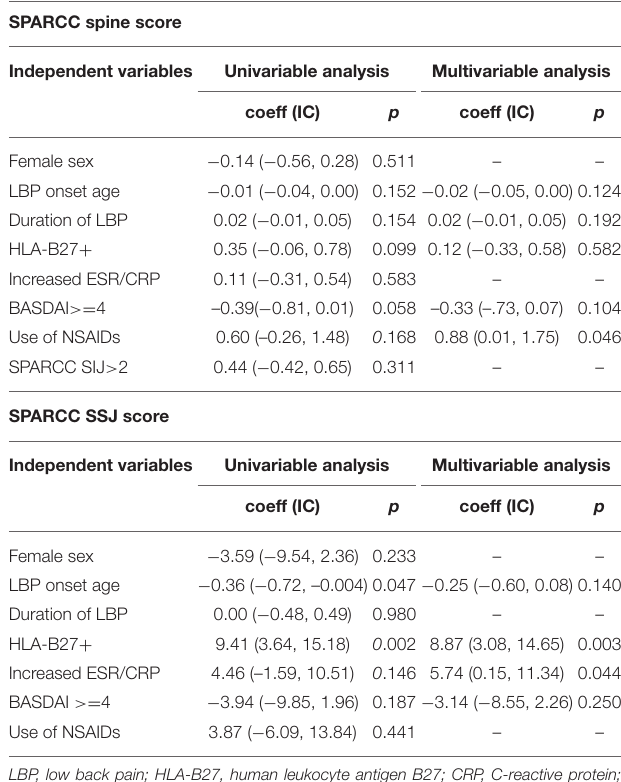
index;NSAIDs,non-steroidalantiinflammatorydrugs;SPARCC,spondyloarthritisresearch consortium of Canada; SIJ, sacroiliac joints; T24, 24